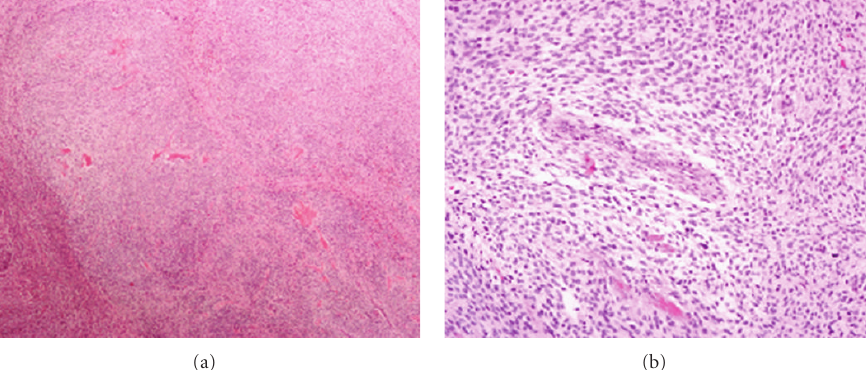
Figure 5: Endometrial stromal sarcoma, low grade is circumscribed from the surrounding myometrium (a), × 40; and higher magnification of endometrial stromal sarcoma shows round uniform tumor cells resembling the stroma of proliferative endometrium with low mitotic rate (b), ×